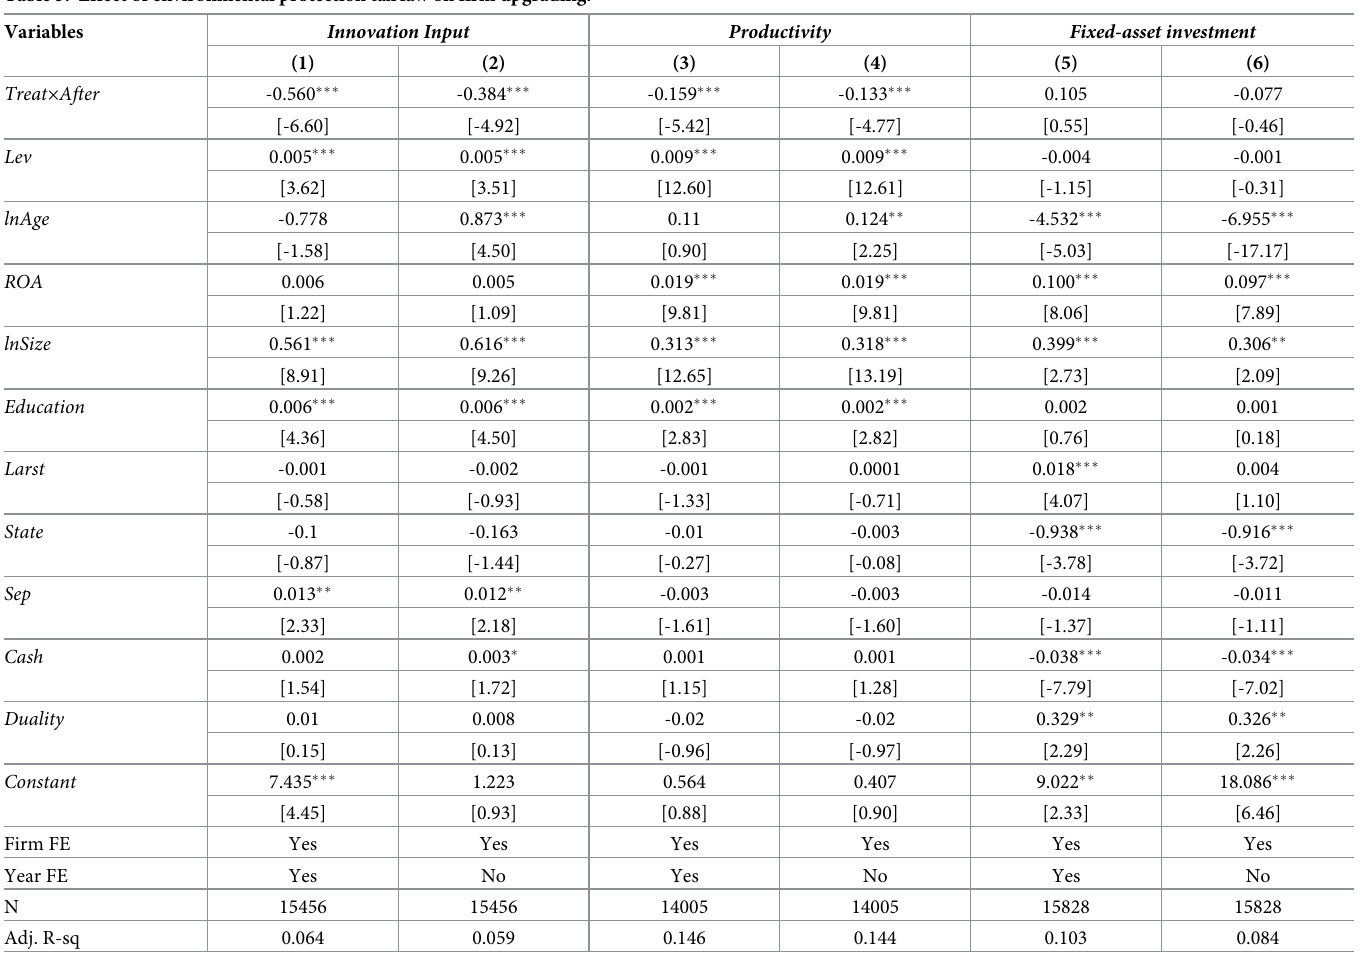
Table 5. Effect of environmental protection tax law on firm